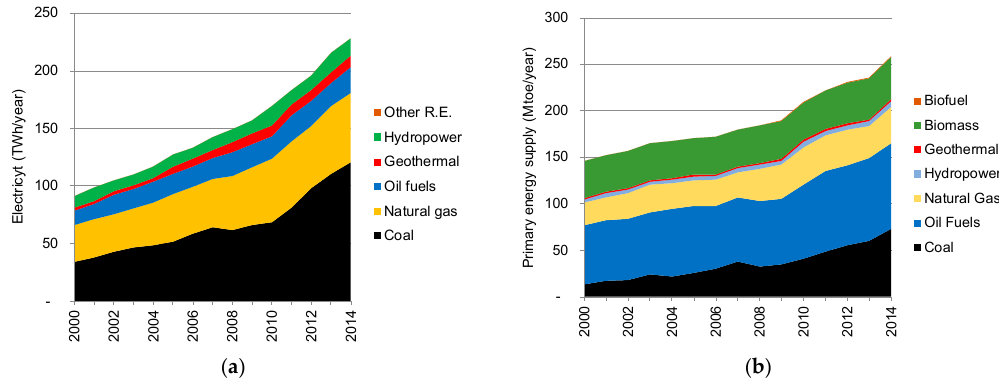
Figure 2. Indonesia’s current power generation and primary energy mix. ( a ) Power generation mix; and ( b ) primary energy supply. R.E.: Renewable Energy.